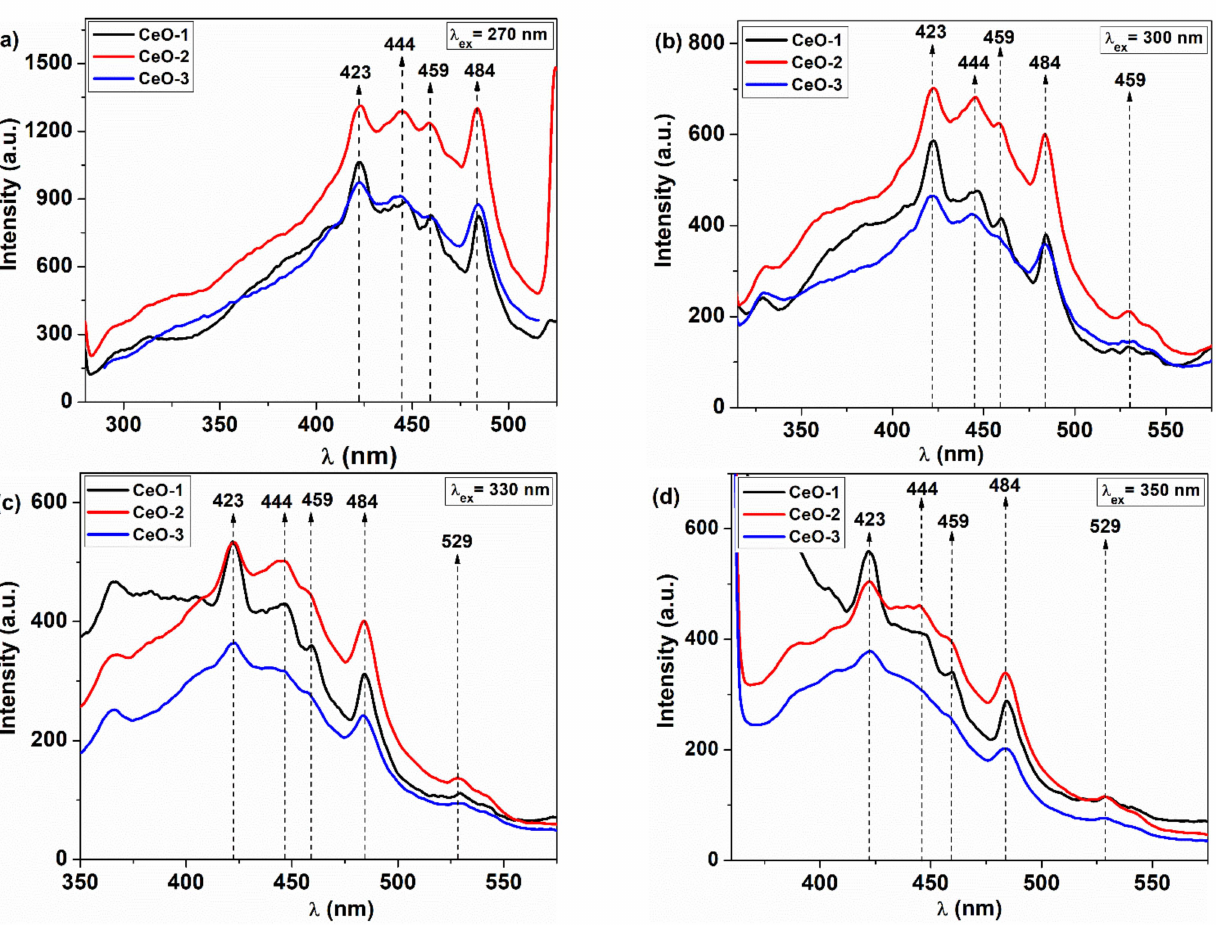
Figure 9. Fluorescence spectra of cerium oxide nanoparticles for different excitation wavelengths: ( a ) 270 nm, ( b ) 300 nm, ( c ) 330 nm, ( d ) 350